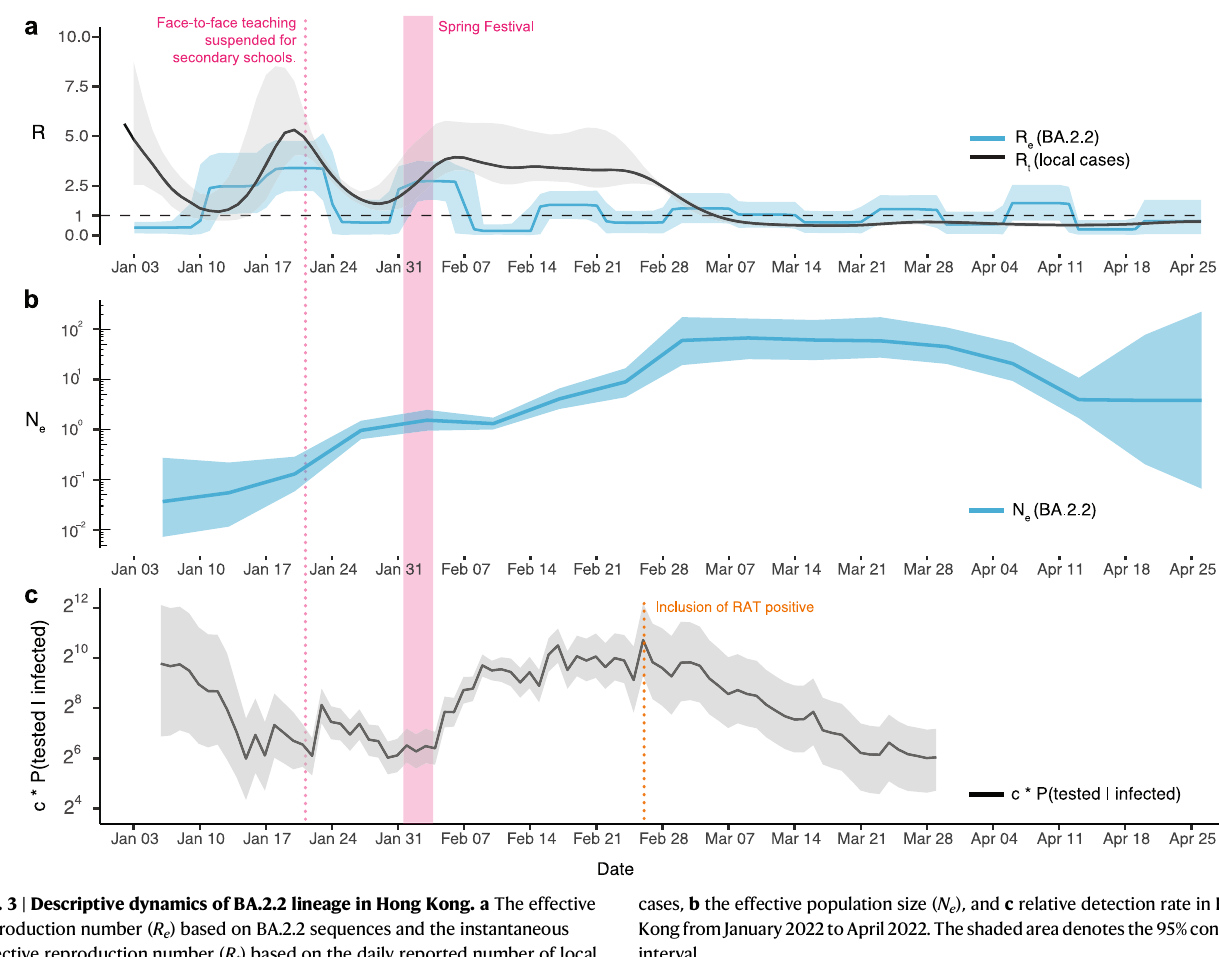
cases, b the effective population size ( N e ), and c relative detection rate in Hong KongfromJanuary2022toApril2022.Theshadedareadenotesthe95%con fi dence